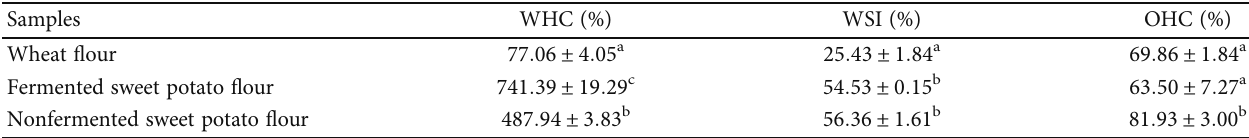
Table 2: Water holding capacity, water solubility index, and oil holding capacity of fl ours from wheat, fermented, and nonfermented sweet